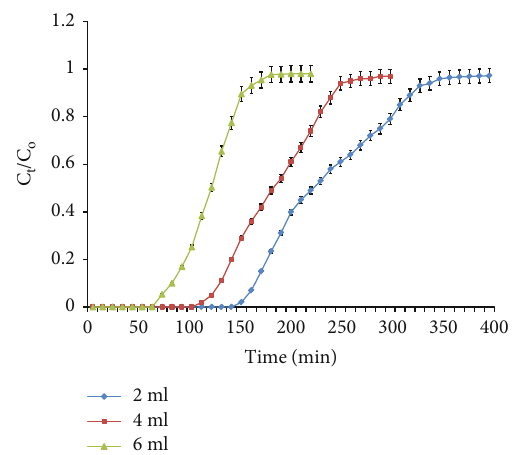
Figure 2: E ff ect of fl ow rate on breakthrough curves obtained for the removal of Pb 2+ by ZSM-5/AC ( fi xed column length 2cm, initial metal concentration 250mgL -1 , pH 6, 303 ° C, and error bars represent the standard deviation at n = 3 ).